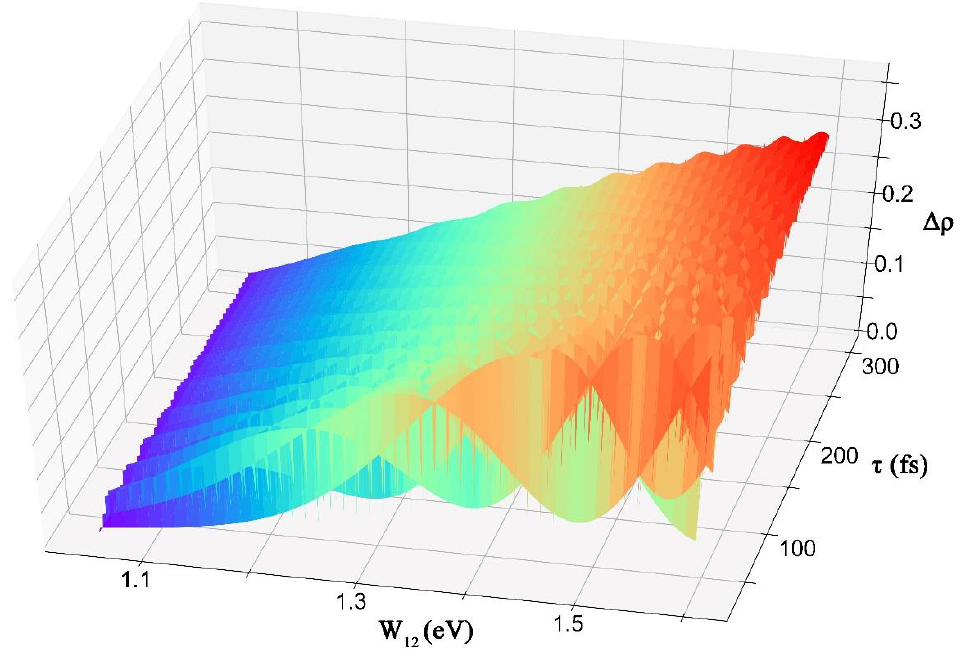
Figure 4. Δ ρ , the probability difference of states |3> and |1>, varies with ω 12 and pulse width. When the pulse width is less than 100 fs and ω 12 increases, Δ ρ increases with dramatic fluctuation. When the pulse width is larger than 100 fs, ω 12 = 1.6, and ω 23 = 0.5, Δ ρ approximately stabilizes at 0.28.